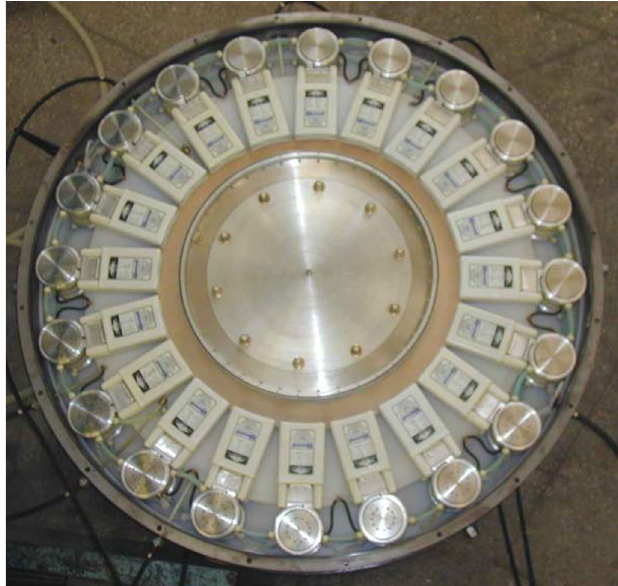
FIG. 2. (Color) LTD-II cavity at Sandia National Laboratories.